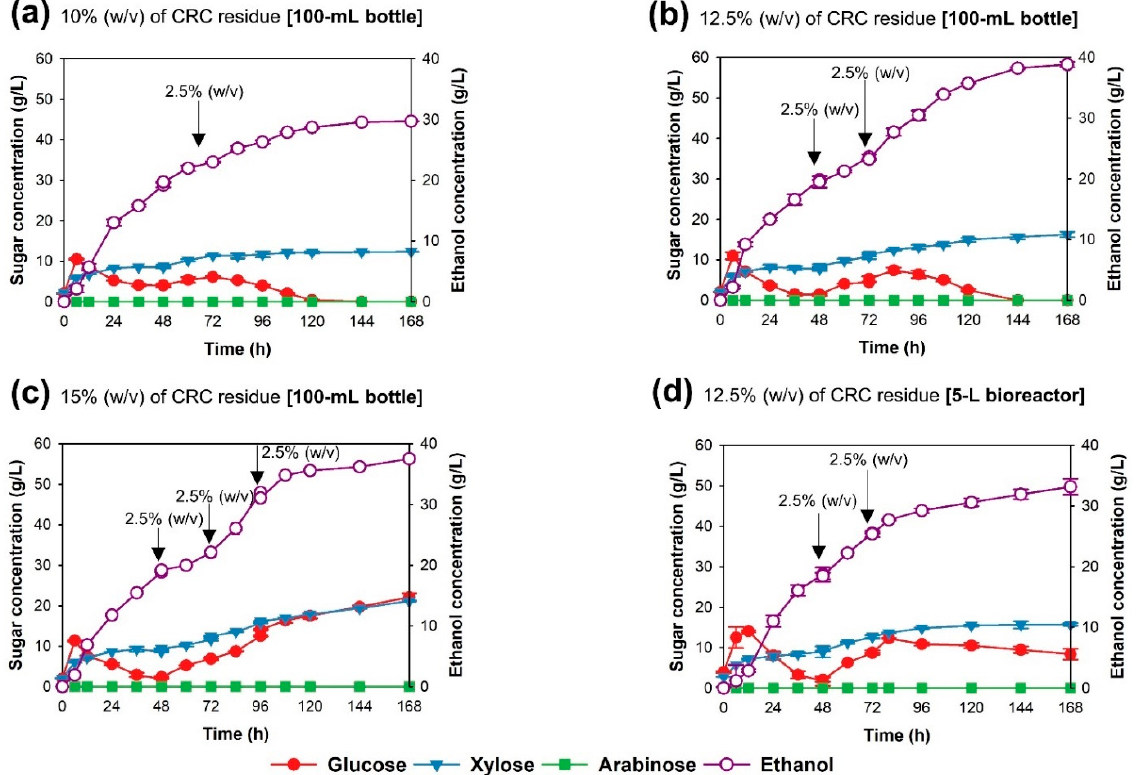
Figure 4. Time course of ethanol production from cellulose-rich corncob residue by the thermotolerant S. cerevisiae TC-5 via fed-batch simultaneous saccharification and fermentation, using 10 ( a ), 12.5 ( b ), and 15% ( c ) ( w / v ) cellulose-rich corncob residue, conducted in a 100-mL laboratory bottle at 40 °C for 168 h; time course of ethanol production via fed-batch simultaneous saccharification and fermentation using 12.5% ( w / v ) cellulose-rich corncob residue by the thermotolerant S. cerevisiae TC-5, conducted in a 5-L bioreactor at 40 °C for 168 h ( d ).